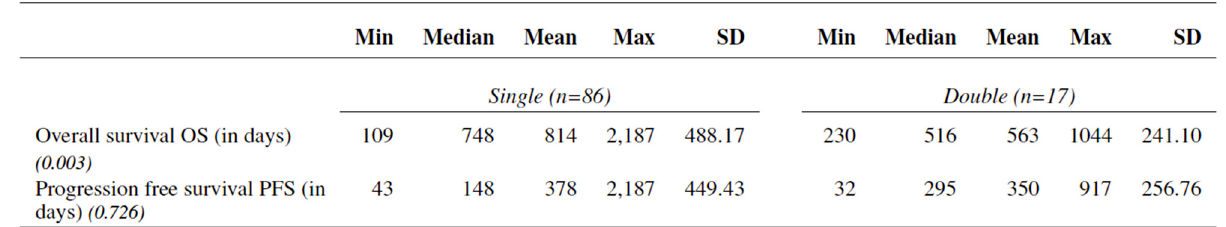
Figure 10. Overall survival OS and progression free survival PFS of female and male patients with advanced melanoma treated with single vs. double ICI.